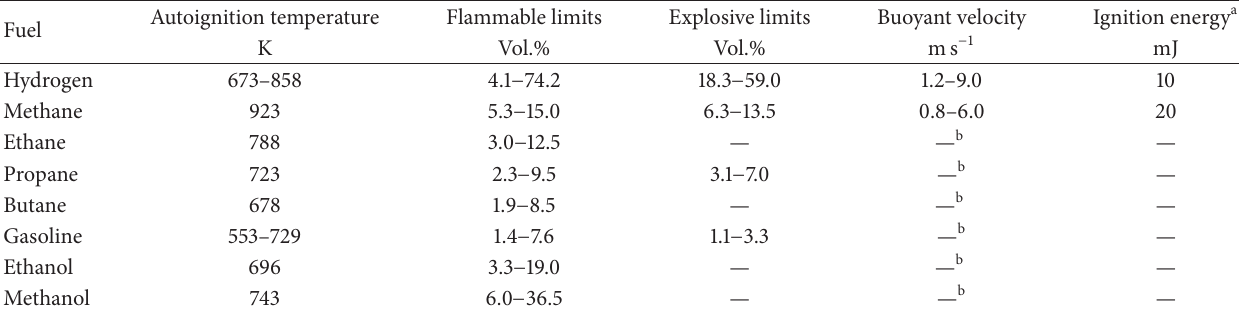
Table 2: Comparison of fuel safety properties in air [18, 24, 25, 27].